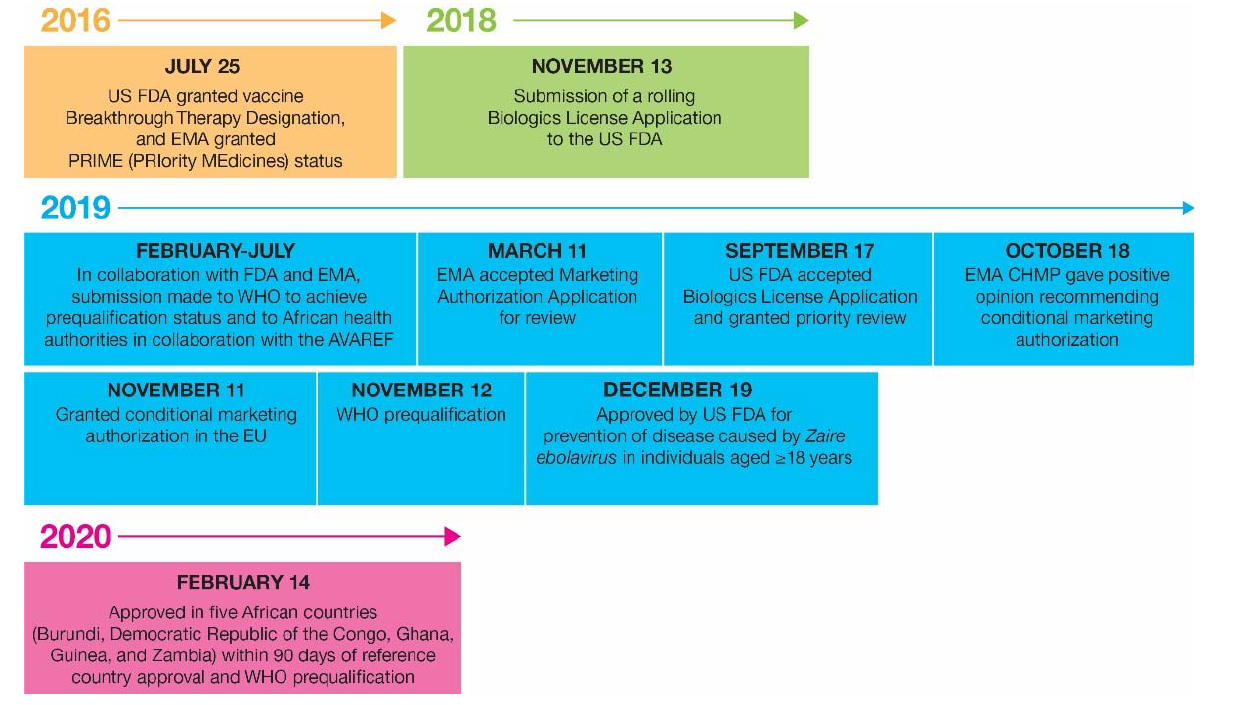
Figure 3. Regulatory timeline for rVSV Δ G ‐ ZEBOV ‐ GP product registration. AVAREF, African Vac ‐ cine Regulatory Forum; CHMP, Committee for Medicinal Products for Human Use; EMA, European Medicines Agency; EU, European Union; FDA, Food & Drug Administration; U.S., United States; WHO, World Health Organization.